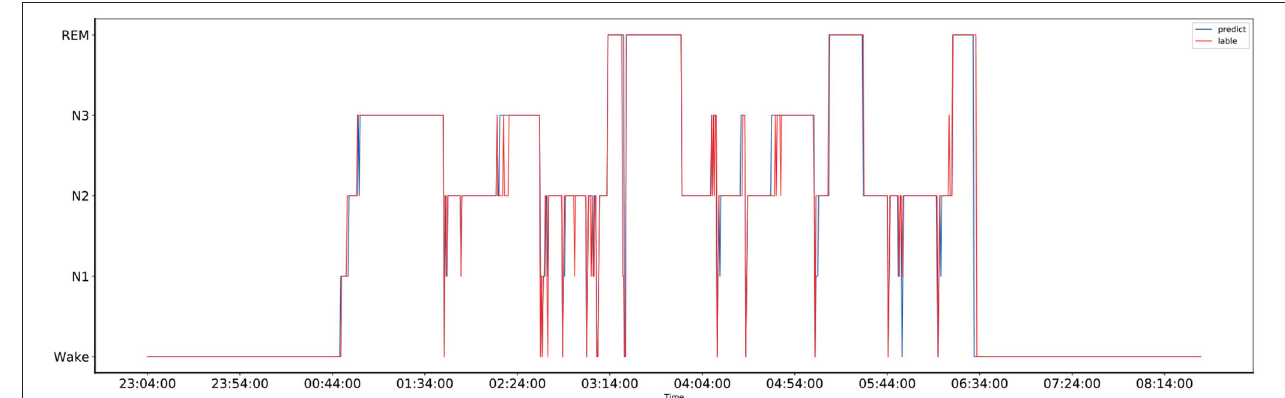
FIGURE 4 | The comparison of the one-night sleep data diagrams, of which one was obtained by manual sleep data staging by a sleep expert and another one was obtained by automatically sleep staging by the proposed model, and they are represented by the red and blue lines, respectively.